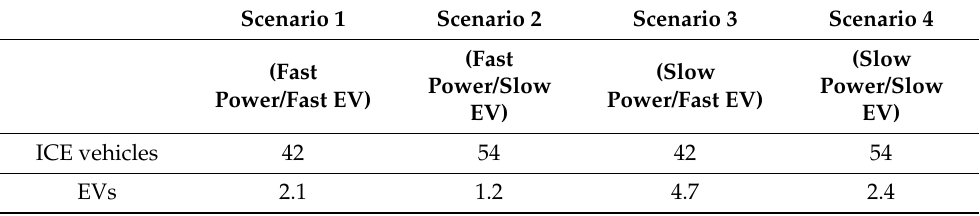
Table 4. Total cumulative passenger vehicle CO 2 emissions from 2020 to 2045 on Oahu by Scenario, (based on faster and slower projections for both the renewable resources on the power grid, and for the rate of EV adoption,